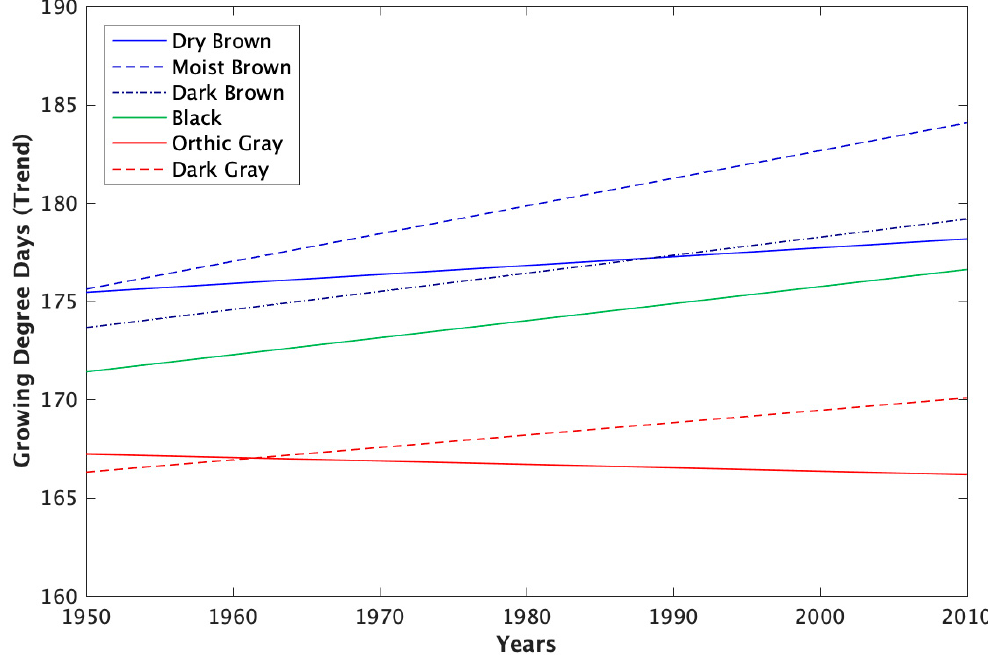
Figure 7. Growing season (May–August) total precipitation (mm) (1885–2016) for all soil zones.